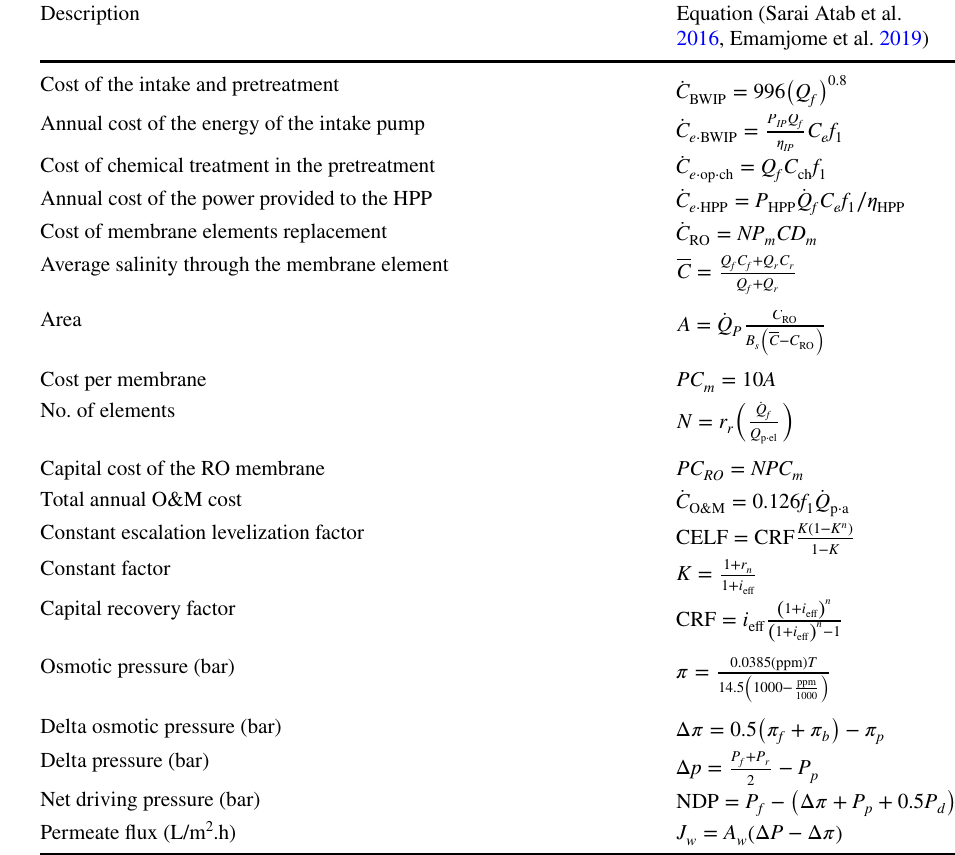
Table 1 Equations of calculation of the capital and operating cost